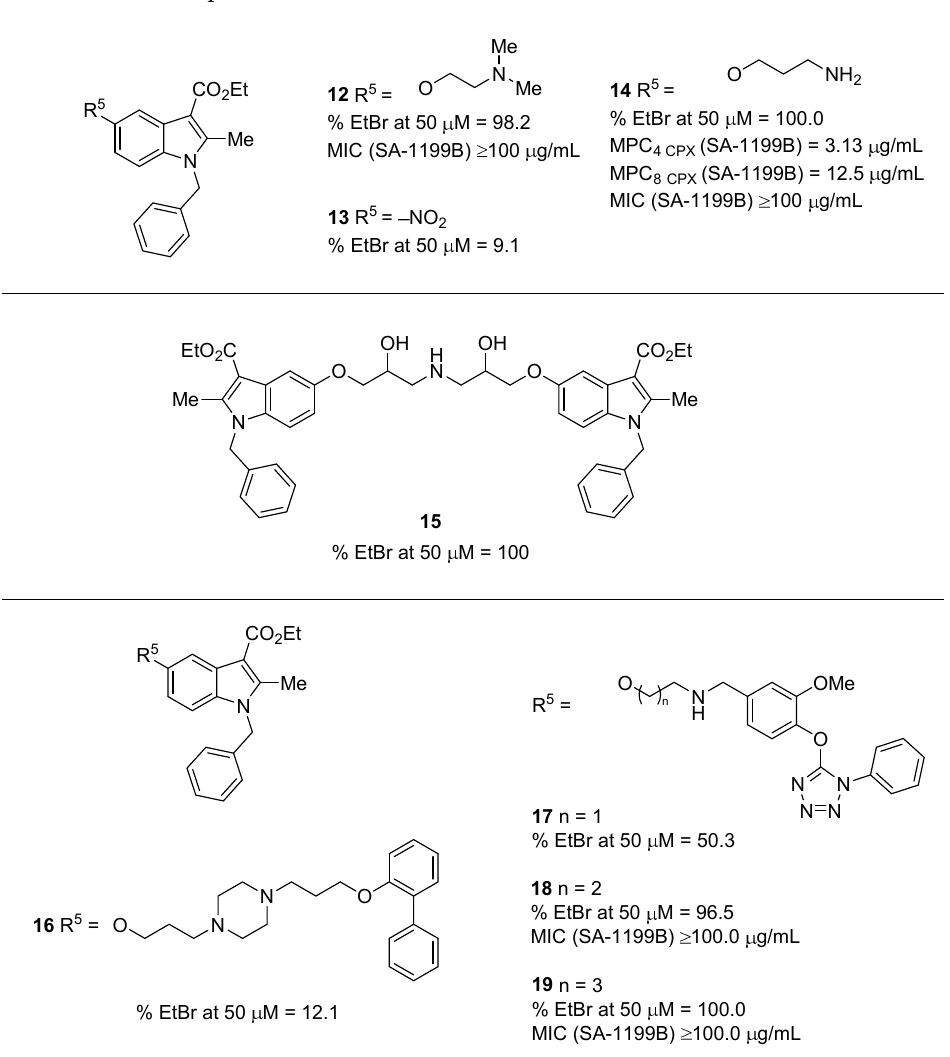
Figure 5. N -1 substituted indole derivatives as NorA EPIs.